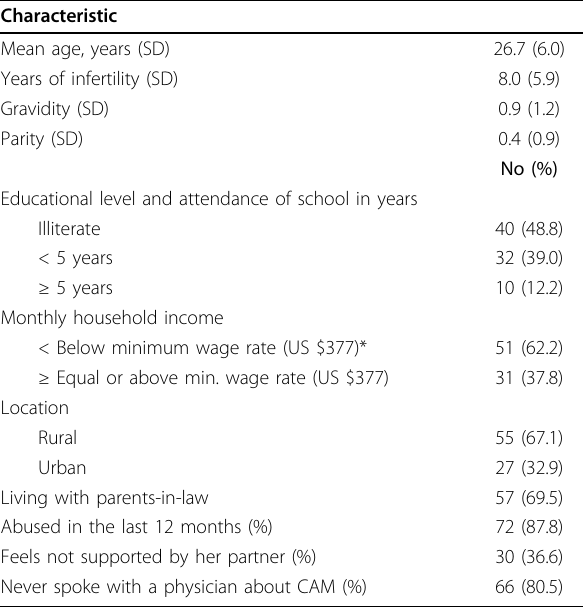
Table 1 Characteristics of infertile patients who used CAM in Van, Turkey 2009 (n =